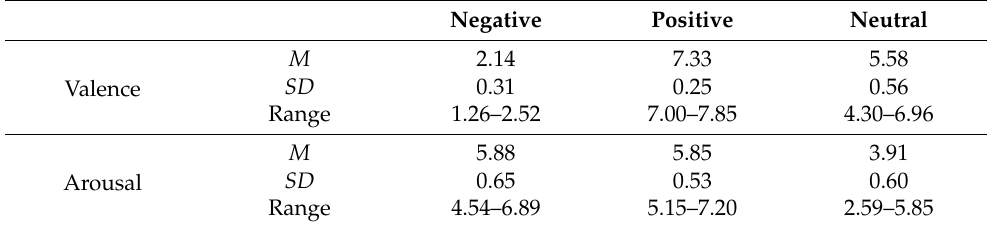
Table 1. Mean valence and arousal ratings of negative, positive, and neutral picture